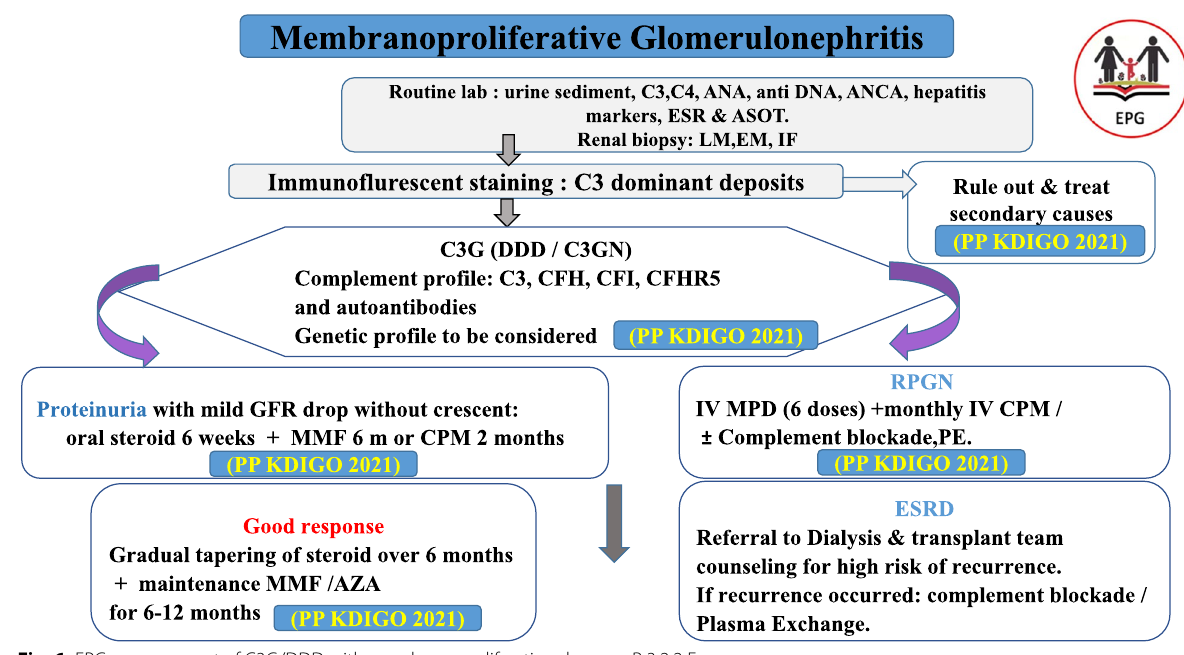
Fig. 6 EPG management of C3G/DDD with membranoproliferative changes. R 3.2.2 F